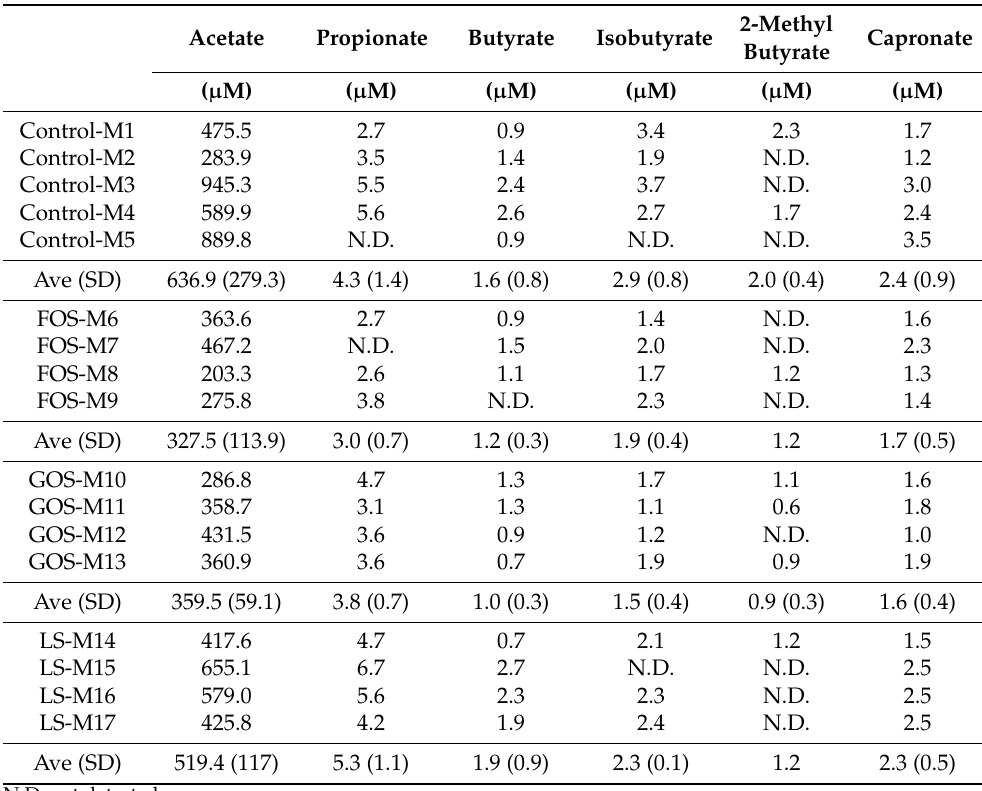
Table 6. A titer of primary short-chain fatty acids in each